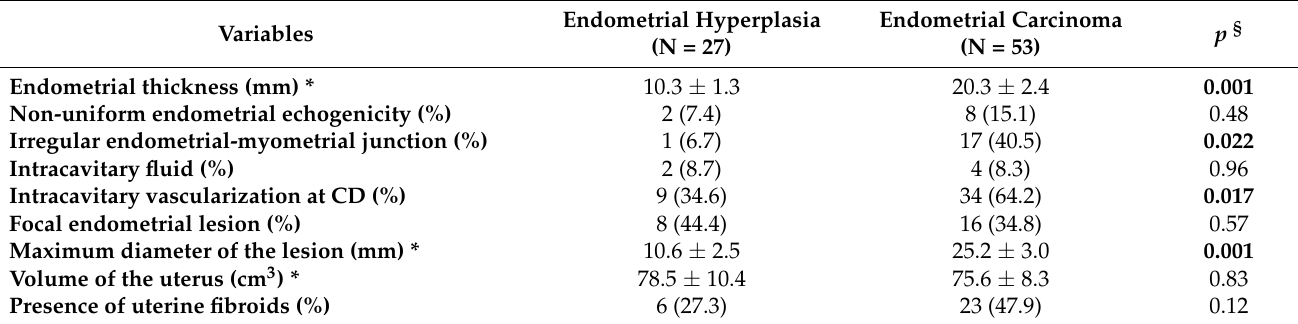
Table 3. Ultrasound features of the endometrial lesions in the two groups.